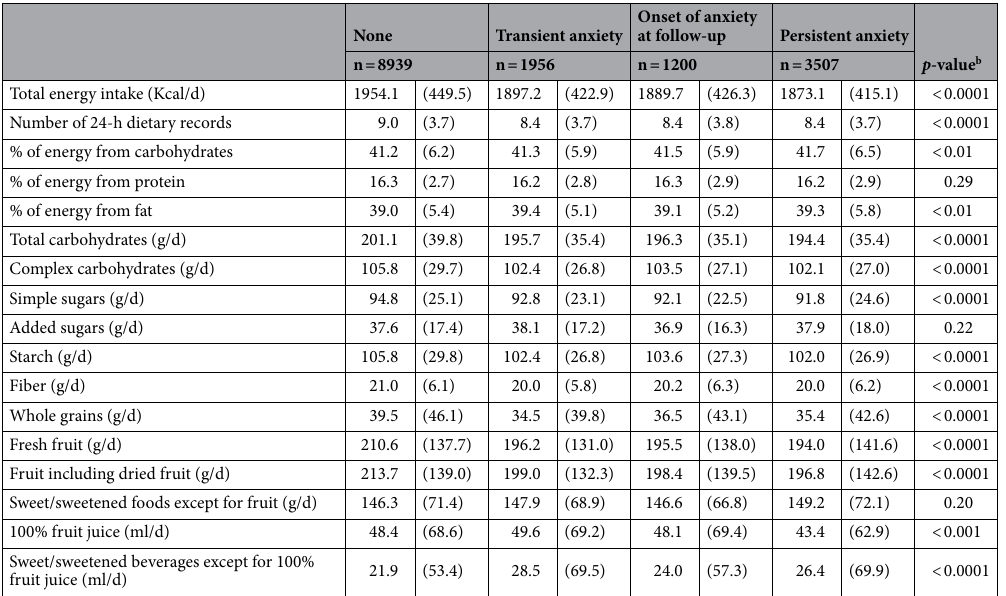
Table 2. Baseline dietary data according to anxiety status a (N = 15,602; NutriNet-Santé cohort; France). Nutrient/food intakes were adjusted for total energy intake by the residual method. Values refer to mean (SD). Values are rounded off to one decimal place, except the p -values. 1 kcal = 4.1868 kJ. a Anxiety status assessed with the trait subscale of Spielberger’s State-Trait Anxiety Inventory form Y (STAI-T). STAI-T score > 40 points considered as high general anxiety; anxiety categories as follows: (1) None = no reported high general anxiety at any time point; (2) Transient anxiety = high general anxiety reported only at baseline; (3) Onset of anxiety at follow-up = high general anxiety reported only at follow-up; (4) Persistent anxiety = high general anxiety reported at baseline and follow-up. b P -values obtained from ANOVA.